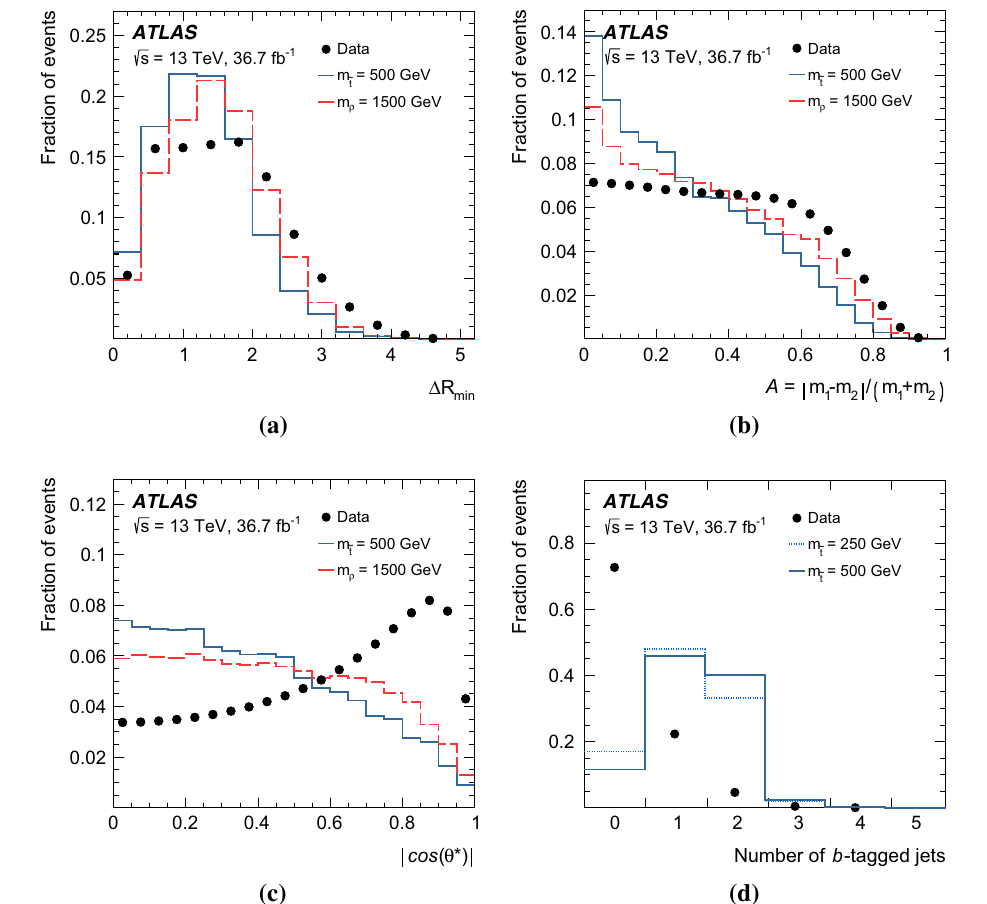
Fig. 2 The distributions of the ( a ) smallest angular separation between the two jets in a pair ( (cid:10) R min ), the ( b ) mass asymmetry ( A ), the ( c ) pair production angle | cos (θ ∗ ) | and the ( d ) multiplicity of b -tagged jets. The observed data (black dots) are compared with the distributions expected from a top squark with a mass of 250 GeV (solid blue line)